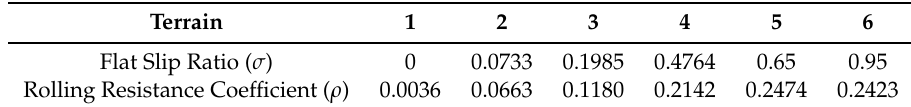
Table 4. Equivalent parameters of the six